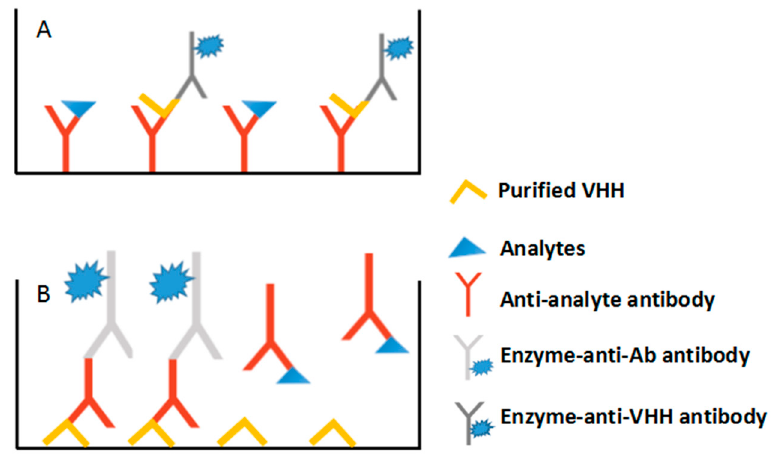
Figure 5. Anti-idiotypic VHH-based Immunoassay. ( A ) Anti-idiotypic VHH functions as substitute for analytes. ( B ) Anti-idiotypic VHH functions as a mimic competing antigen.